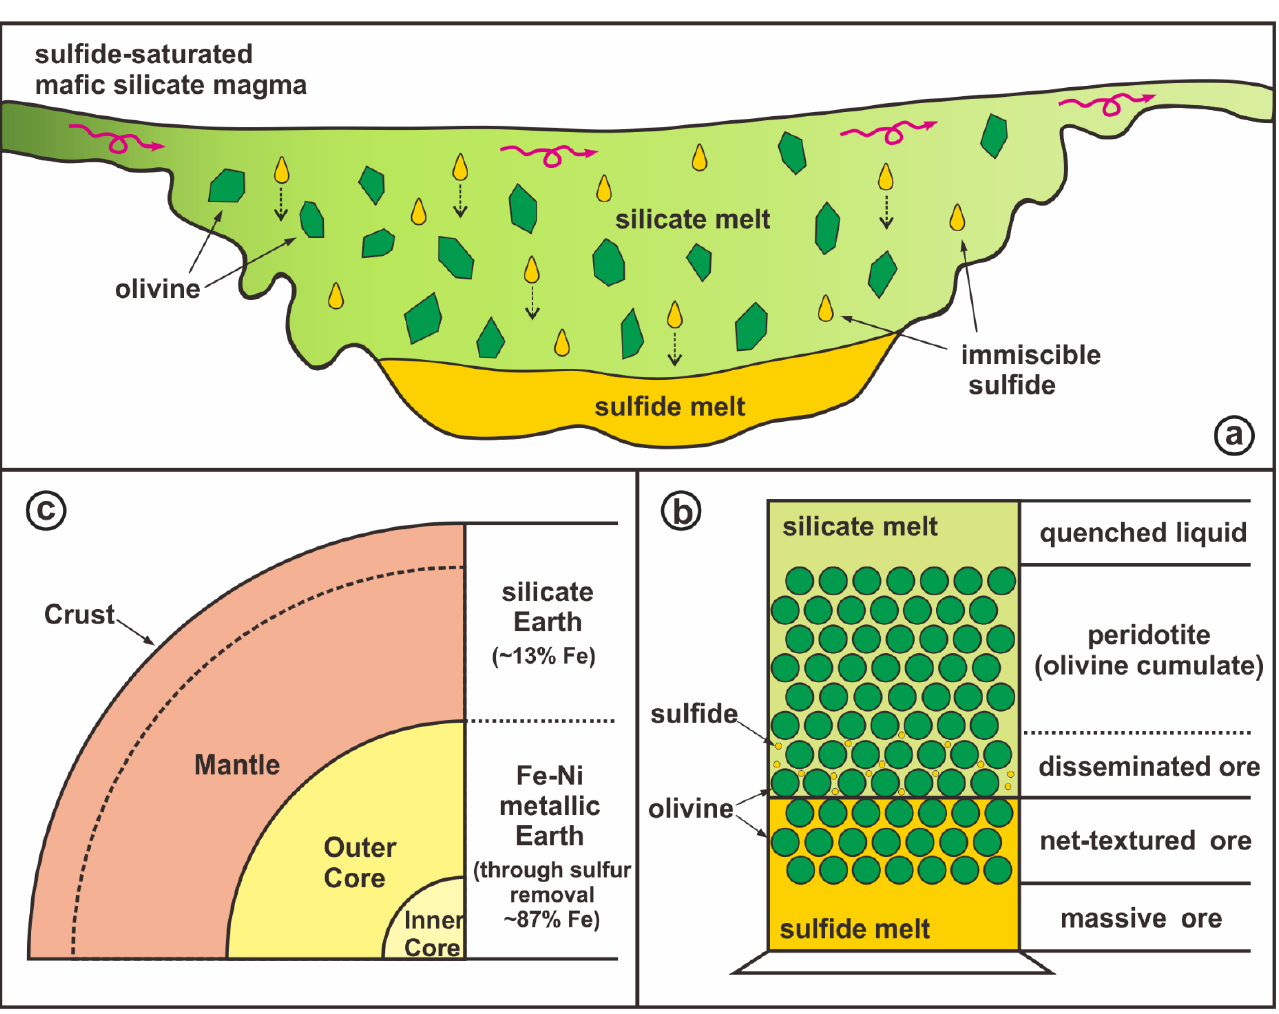
Figure 1. A schematic scenario of magmatic Ni-Cu-Fe sulfide mineralization to illustrate the possible process of core–mantle separation through sulfide-silicate melt segregation. ( a ) Portion of a cross-section illustrating the silicate-sulfide melt segregation in a magma reservoir relevant to the Sudbury-type sulfide ore mineralization (modified from [18]), where the sulfide-saturated mafic magma segregates to immiscible sulfide liquid from the silicate liquid, and the denser sulfide liquid sinks to the bottom while olivine dominated mafic minerals are crystallizing from the silicate liquid [19]. ( b ) Continuation of the process in ( a ), which forms the peridotite of cumulate origin dominated by olivine and varying textured ore types downwards (disseminated, net-textured, and massive ores) as illustrated (modified from [18,20]). ( c ) While the core is largely metallic (Fe, Ni, etc.), we reason that the core separation must have undergone sulfide-silicate segregation due to density difference, and the sulfide melt must have then developed into metallic core through sulfur removal. As the latter process should not cause iron isotope fractionation, the metallic iron will retain the sulfide liquid iron isotope characteristics. Hence, the net-textured ores showing equilibrium contact between silicates and sulfides provide ideal materials for understanding possible iron isotope fractionation between the metallic core and silicate Earth during core formation. We do not consider the effects of deep mantle pressures and temperatures in this strategically important first step study (see text).